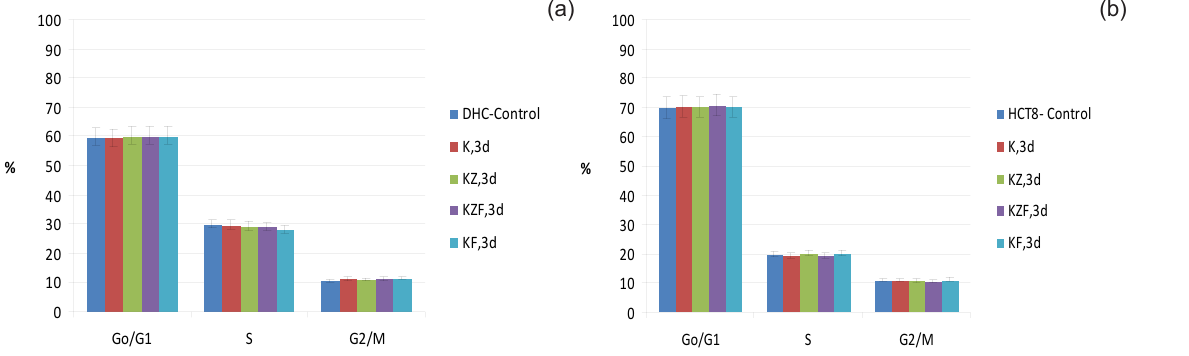
Figure 11. Influence of WMTA (K) and PSC (KZ, KZF and KF) pastes hydrated for 3 days on the cellular cycle phases of: a – DHC; b- HCT 8